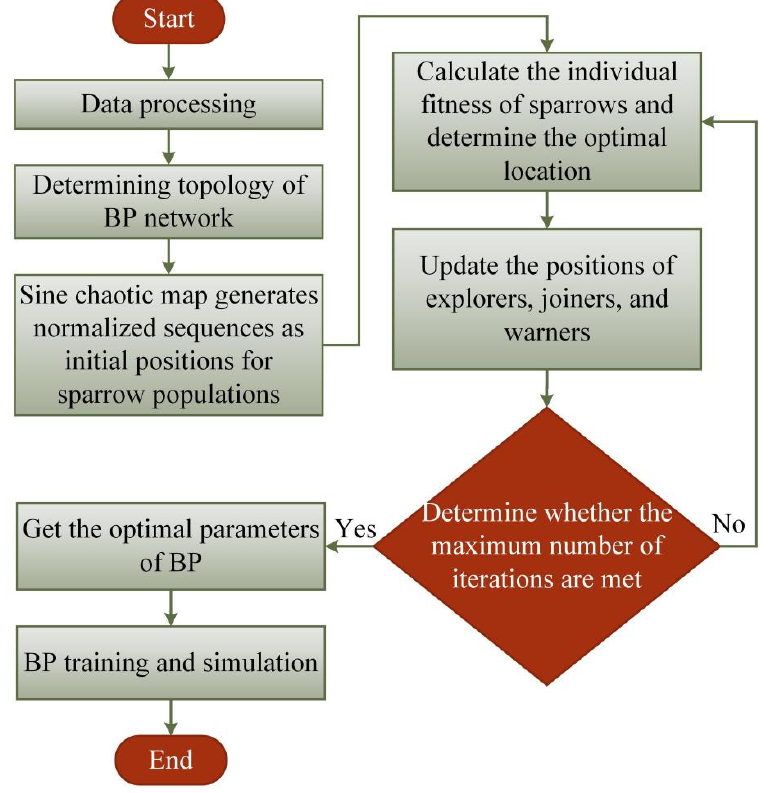
Figure 8. Flowchart of Sine-SSA-BP prediction model.